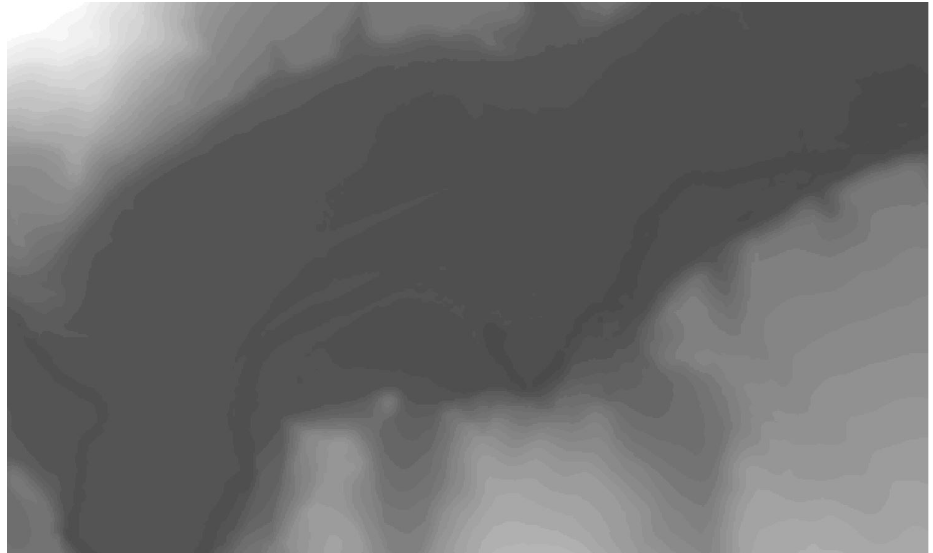
Figure 2. Zoom to a smaller area (red-edged rectangle marked in Figure 1 for more detailed display purposes) Elevation range: [450, 560]